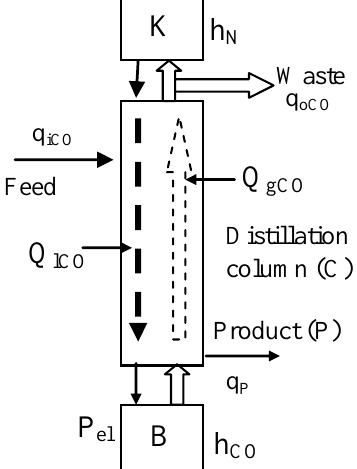
Figure 2. Isotope-separation column simplified scheme, with condenser K, column C, boiler B, input (CO) flow q iCO , waste flow q oCO , product flow q P . internal gaseous flow Q gCO , internal liquid flow Q lCO , electrical power P el , (N) level in the condenser h N.